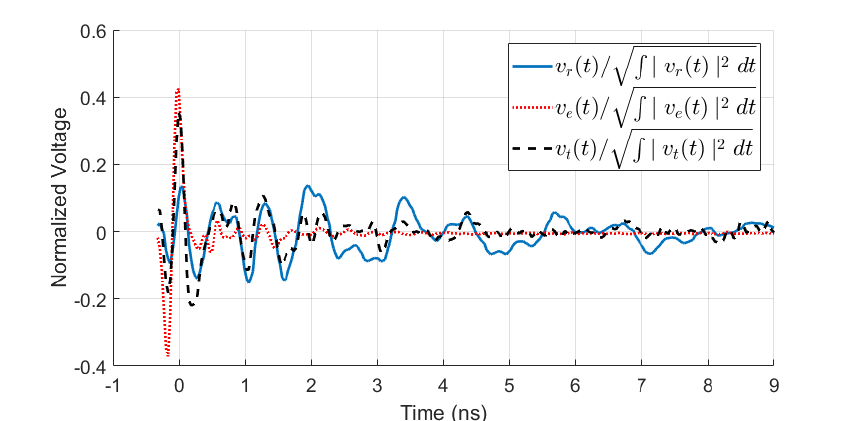
Figure 12. Normalized excitation, received and transmit signals after temporal alignment for maximum